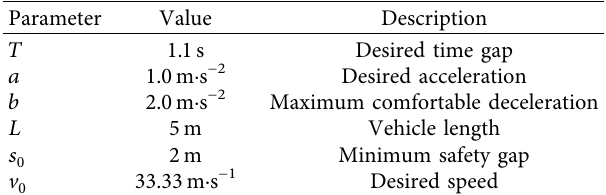
Figure 2: Time gap policy functions. (a) Function form corresponds to equation (3). (b) Function form corresponds to equation (4). Table 1: Parameters of IDM used in this